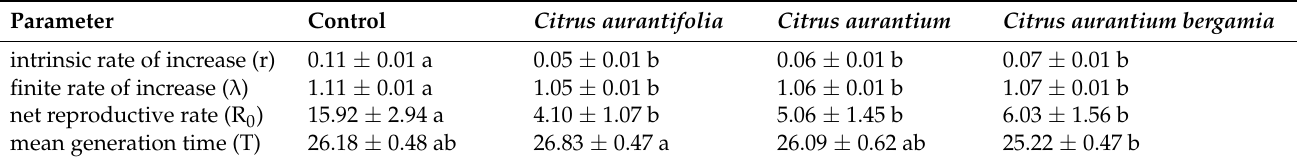
Table 4. Demographic parameters of Tuta absoluta treated with the LC 50 of Citrus aurantifolia, Citrus aurantium and Citrus aurantium bergamia EOs and only acetone (control).